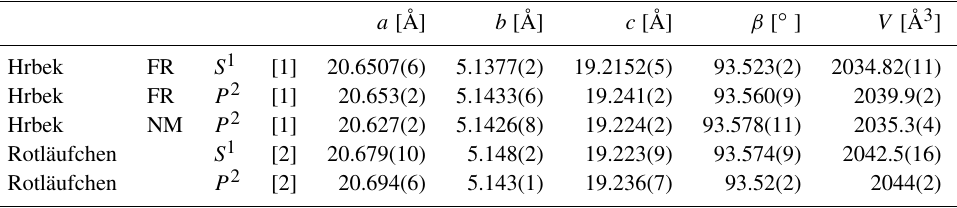
Table 4. Unit-cell parameters for beraunite.